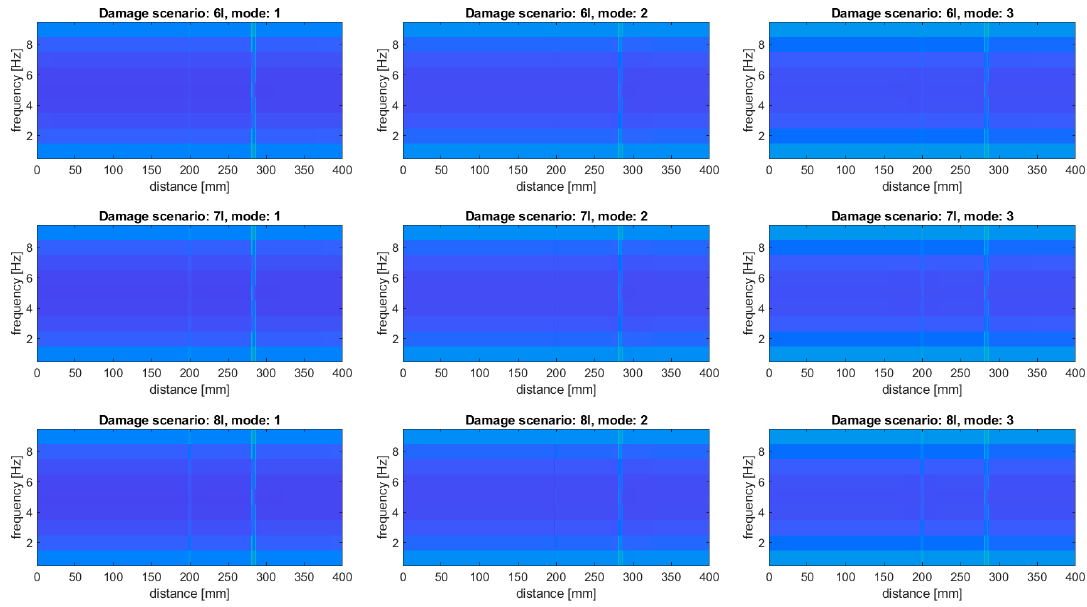
Figure 5. The results of the damage identification for the considered damage scenarios using a baseline-free approach.